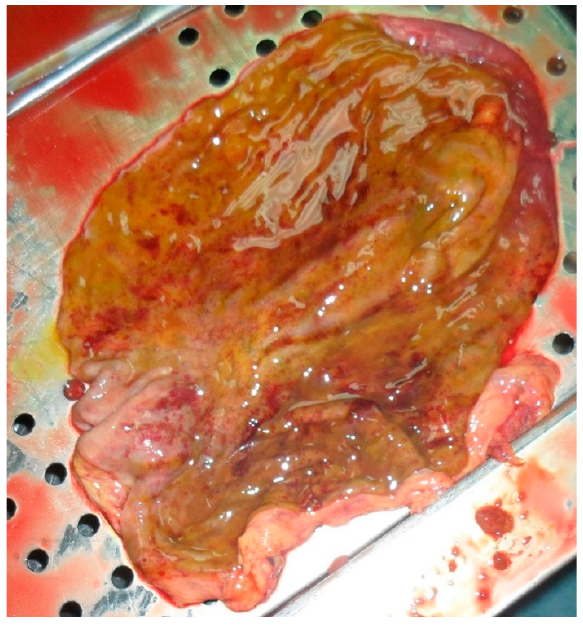
Figure 1. Internal stomach walls with areas of inflammation.